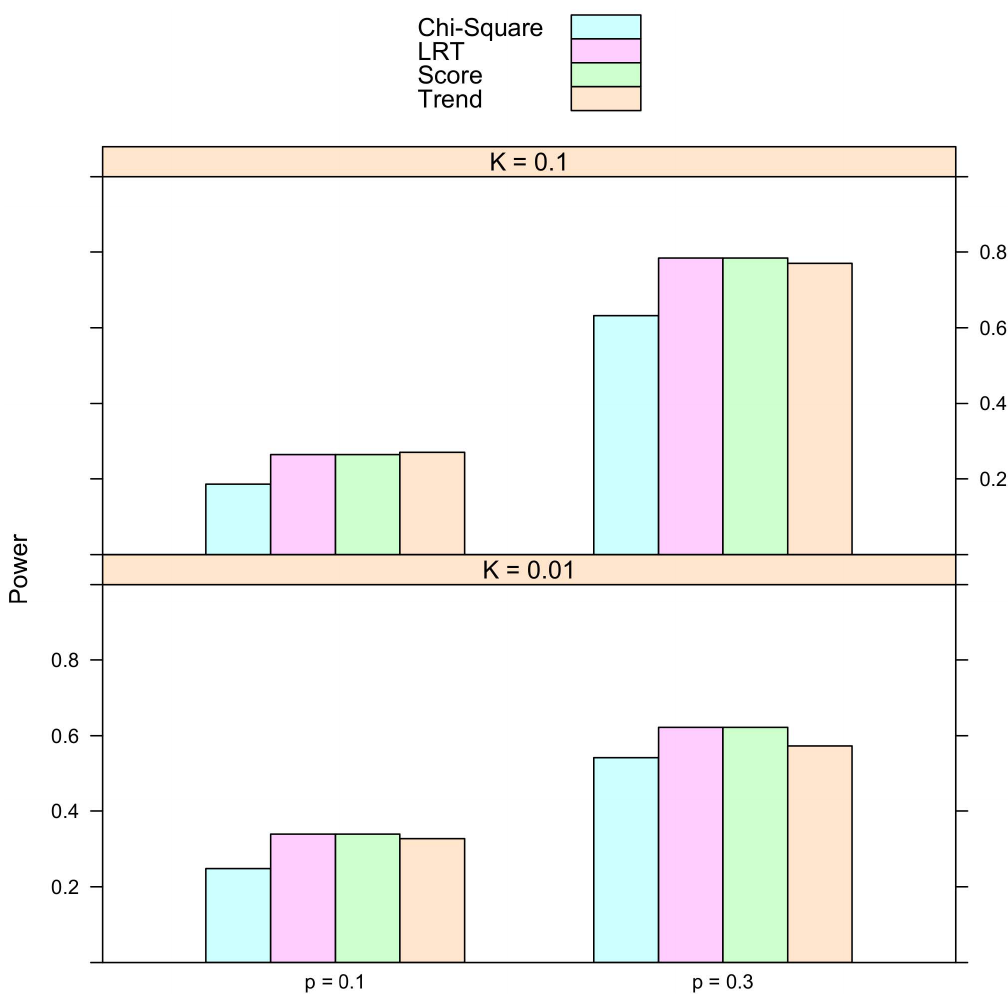
Figure 2. Simulated power for additive model. The relative genotype risks are f 1 = f 0 ~ 1 : 25, f 2 = f 0 ~ 1 : 5 . K represents disease prevalence and p is the frequency of allele a . The abbreviations for the test statistics are the same as in Table 2.